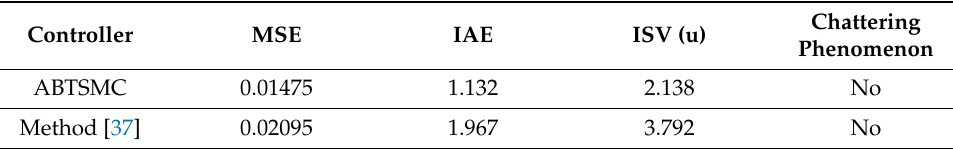
Figure 8. Tracking the healthy state of soma potential by ABTSM and NITSMC.